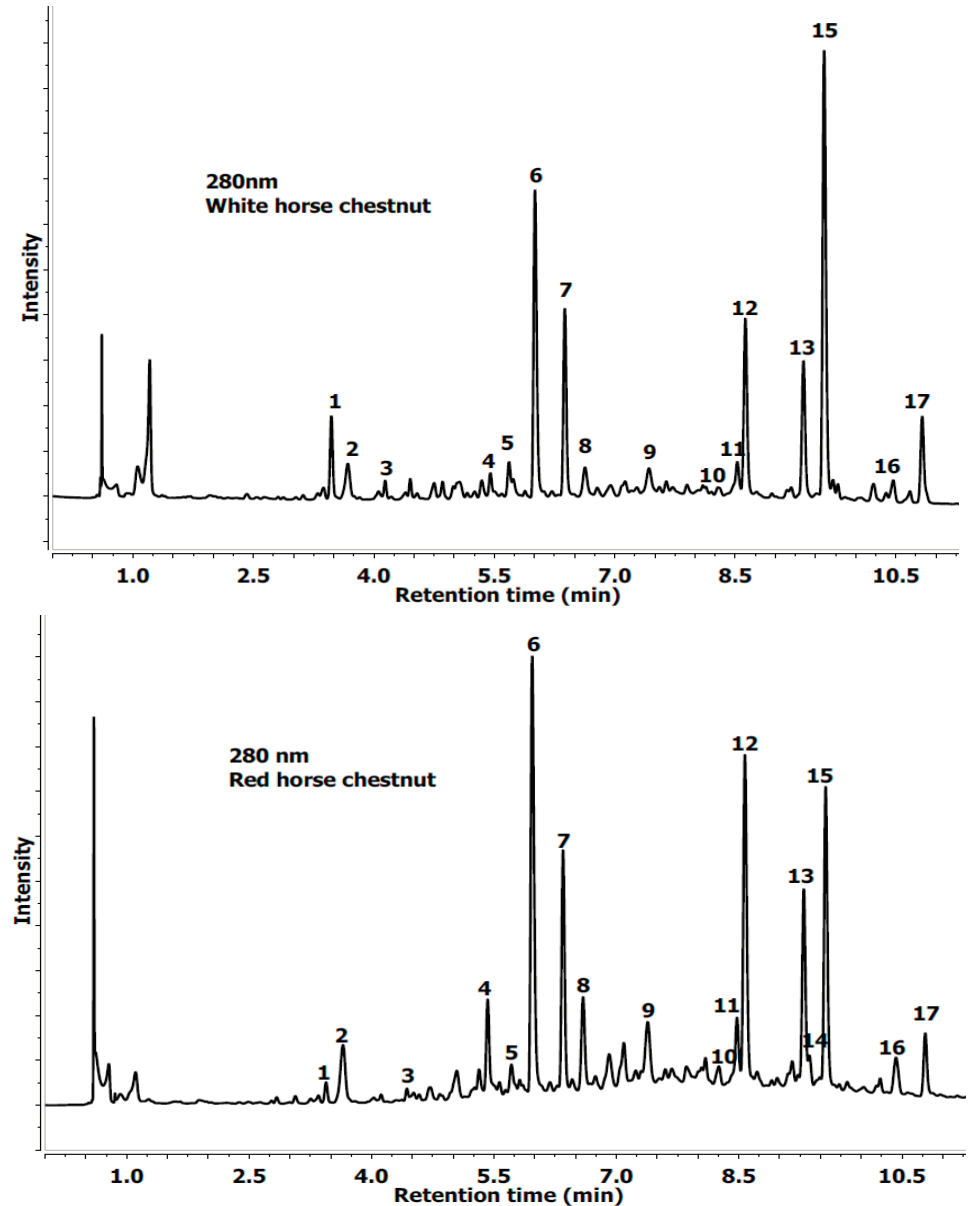
Figure 2. UPLC chromatogram profile of white and red horse chestnut leaves extracts at 280 nm (flavonols). Abbreviations for peak labels see Table